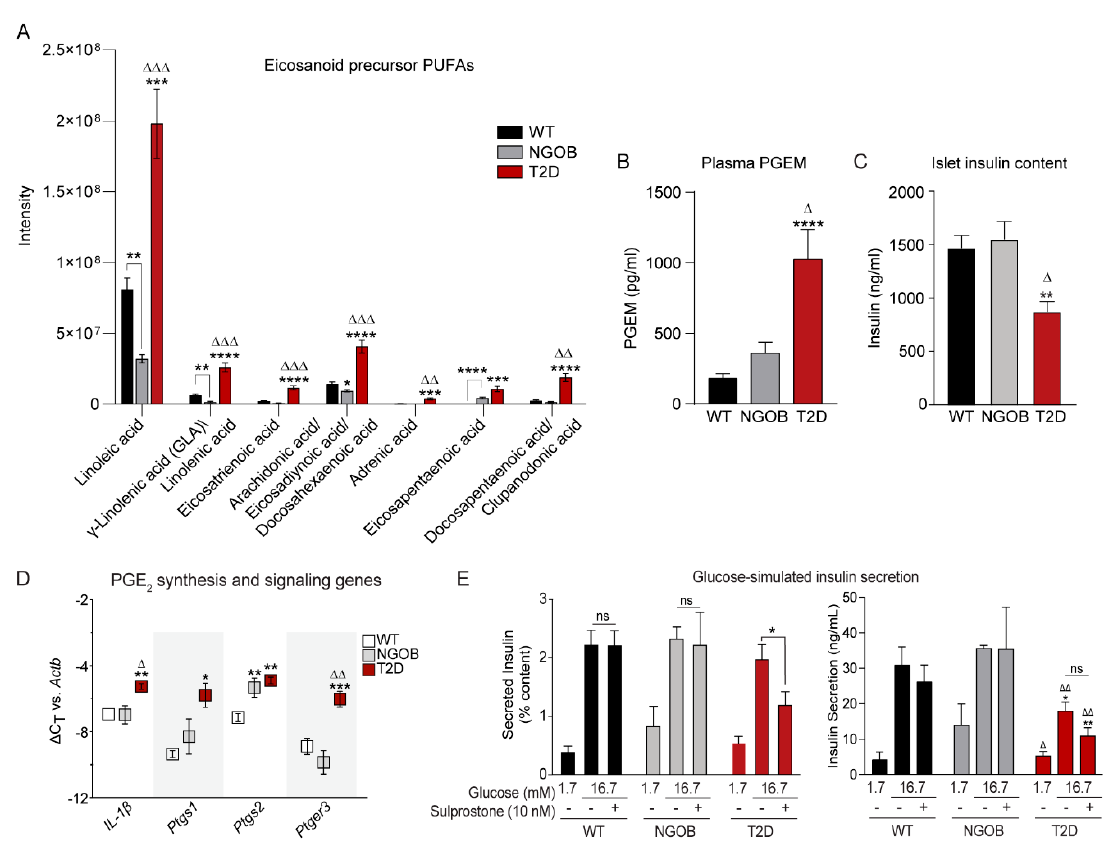
Figure 7. Changes in PGE 2 production and signaling and its role in insulin secretion from WT, NGOB, and T2D BTBR mice: ( A ) comparison of significantly expressed eicosanoid precursors from WT, NGOB, and T2D plasma samples, where data were analyze by multiple t -test with Holm-Sidak test post hoc; ( B ) plasma PGE metabolite concentrations as measured by ELISA ( n = 4–12); ( C ) total islet insulin content from WT, NGOB, and T2D islets, n = 3–12; ( D ) transcript expression of PGE 2 synthetic and signaling enzymes from WT, NGOB, and T2D islets, where data are relative to β -actin, n = 4–6; and ( E ) glucose-stimulated insulin secretion from islets stimulated with 1.7 mM glucose or 16.7 mM glucose ± 10 nM sulprostone. Secreted insulin was normalized to total insulin content (left). Data are plotted as total insulin secreted (right), n = 3–12. Data represent mean ± SEM and were analyzed by two-way ANOVA with Holm-Sidak test post hoc. * p < 0.05, ** p < 0.01, *** p < 0.001, and **** p < 0.0001 compared to WT. Δ p < 0.05, ΔΔ p < 0.001, and ΔΔΔ p < 0.001. ns = not significant.